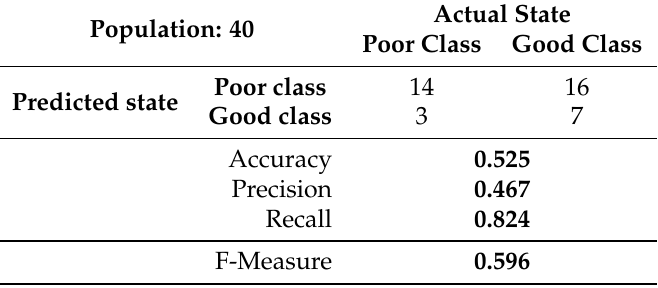
Table 17. Reliability analysis of identification based on an individual software